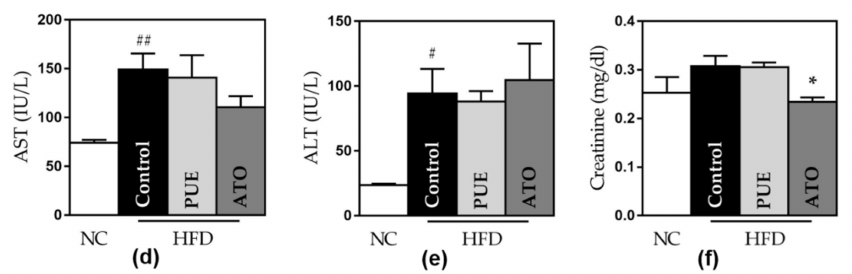
Figure 3. Weight- and safety-related outcomes. ( a ) Bodyweight. ( b ) Liver weight. ( c ) Epididymal fat pads weight and levels of ( d ) AST, ( e ) ALT, and ( f ) creatinine. Data represent mean ± standard error of the mean (SEM). # p < 0.05, ## p < 0.01 and ### p < 0.001 versus the NC group, and * p < 0.05 and **